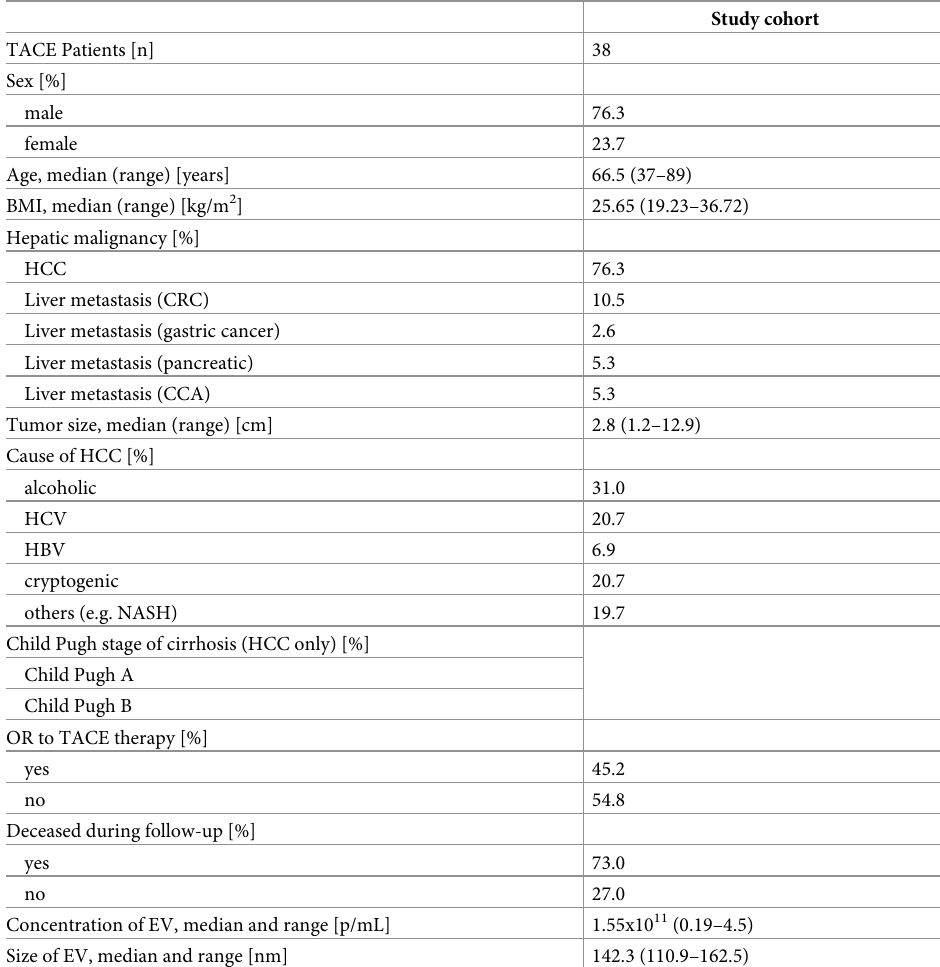
Table 1. Characteristics of study